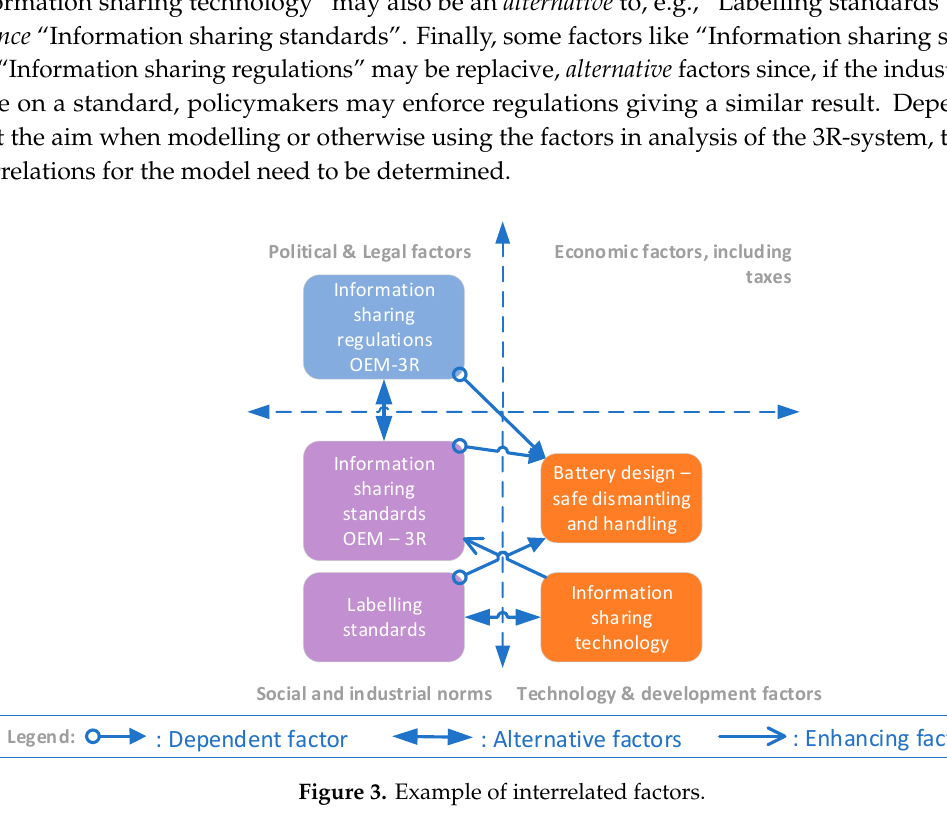
Figure 3. Example of interrelated factors.